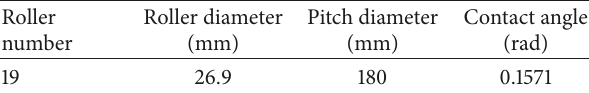
Table 1: The parameters of the test rolling